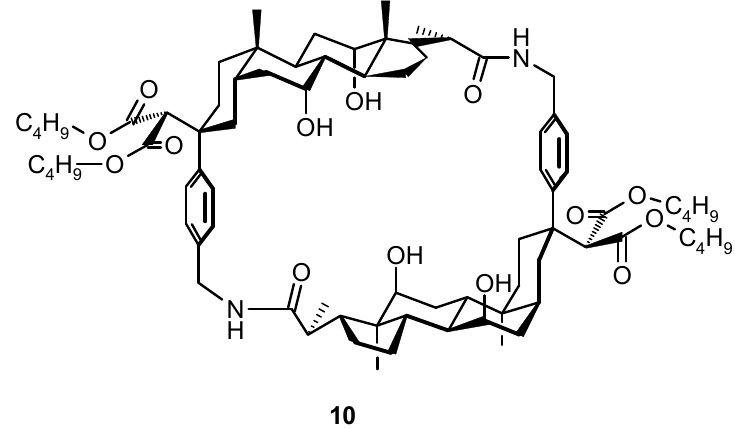
Figure 4. A novel, more soluble and less flexible cholaphane [79].